Question: What type of chart is this?
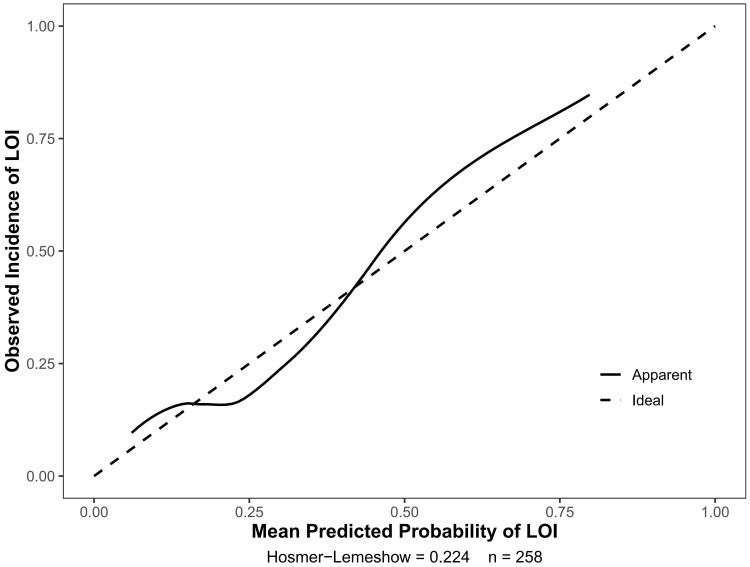
Answer: line